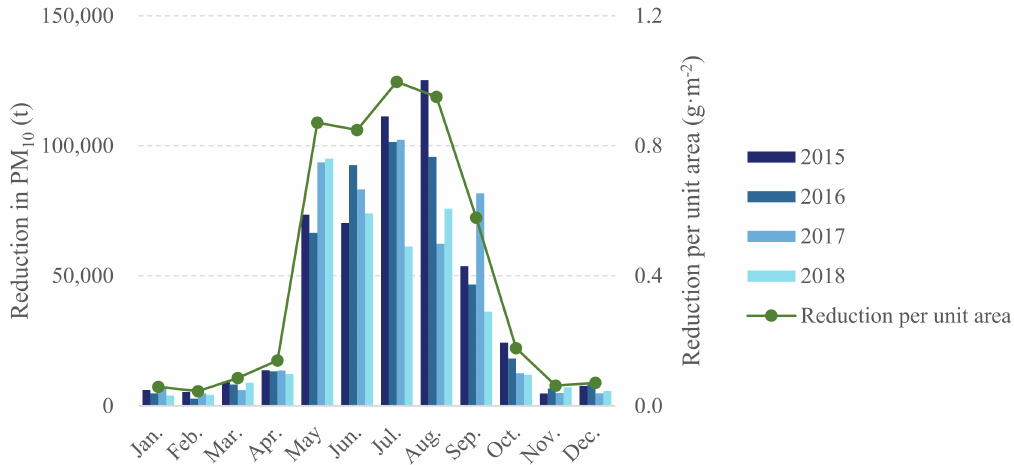
Figure 9. PM 10 removal of each month at an overall scale from 2015 to